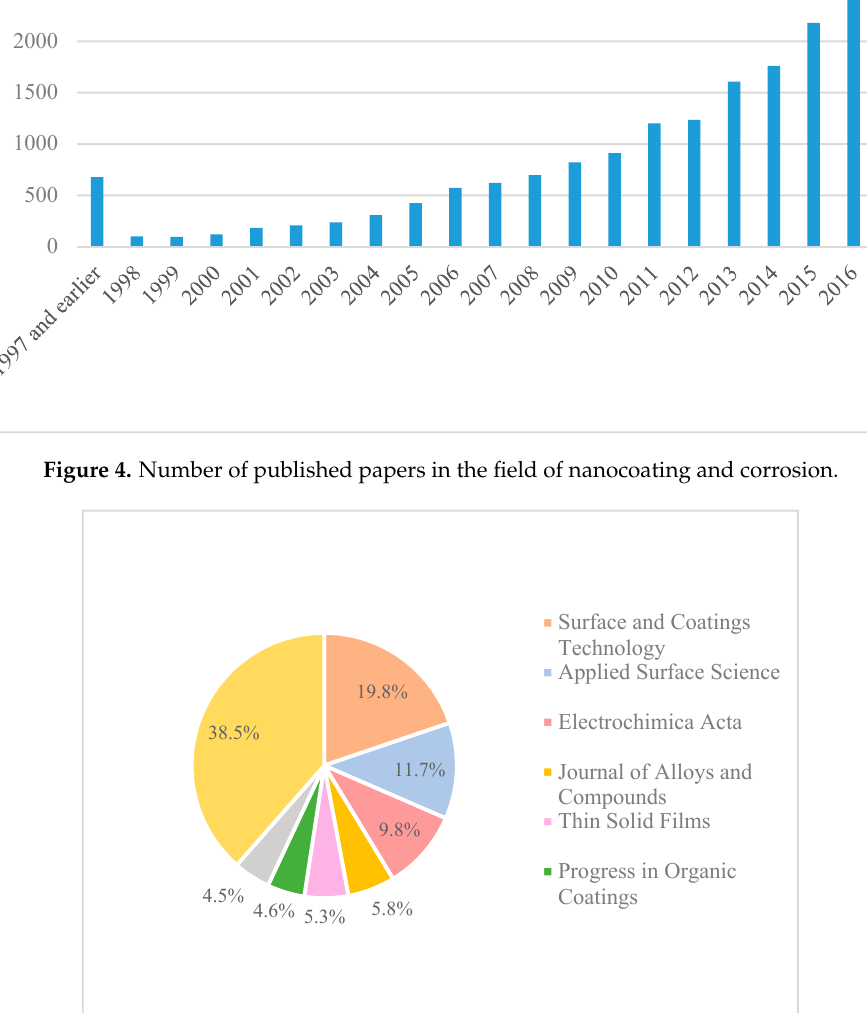
Figure 4. Number of published papers in the field of nanocoating and corrosion.